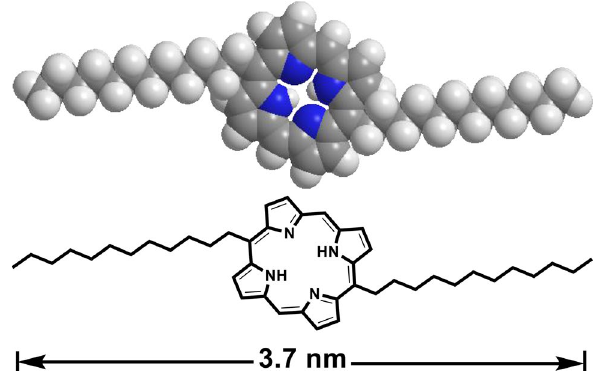
Figure 1. The chemical structure of 5, 15-bisdodecylporphyrin